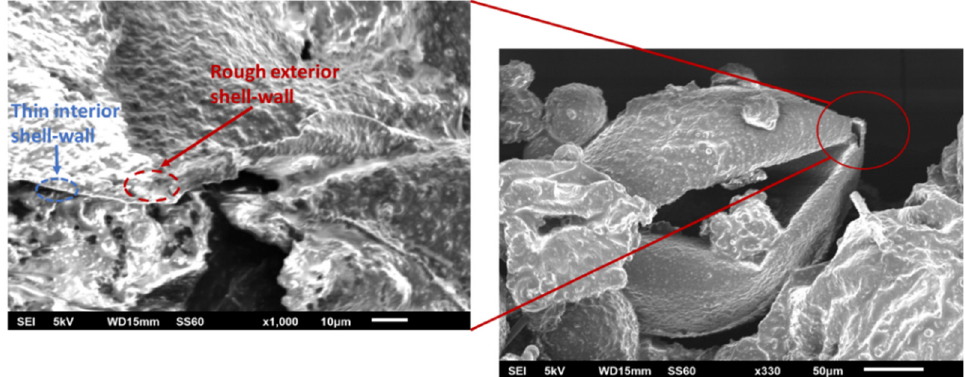
Figure 4. SEM images from capsules confirm the rough exterior and thin interior shell wall.